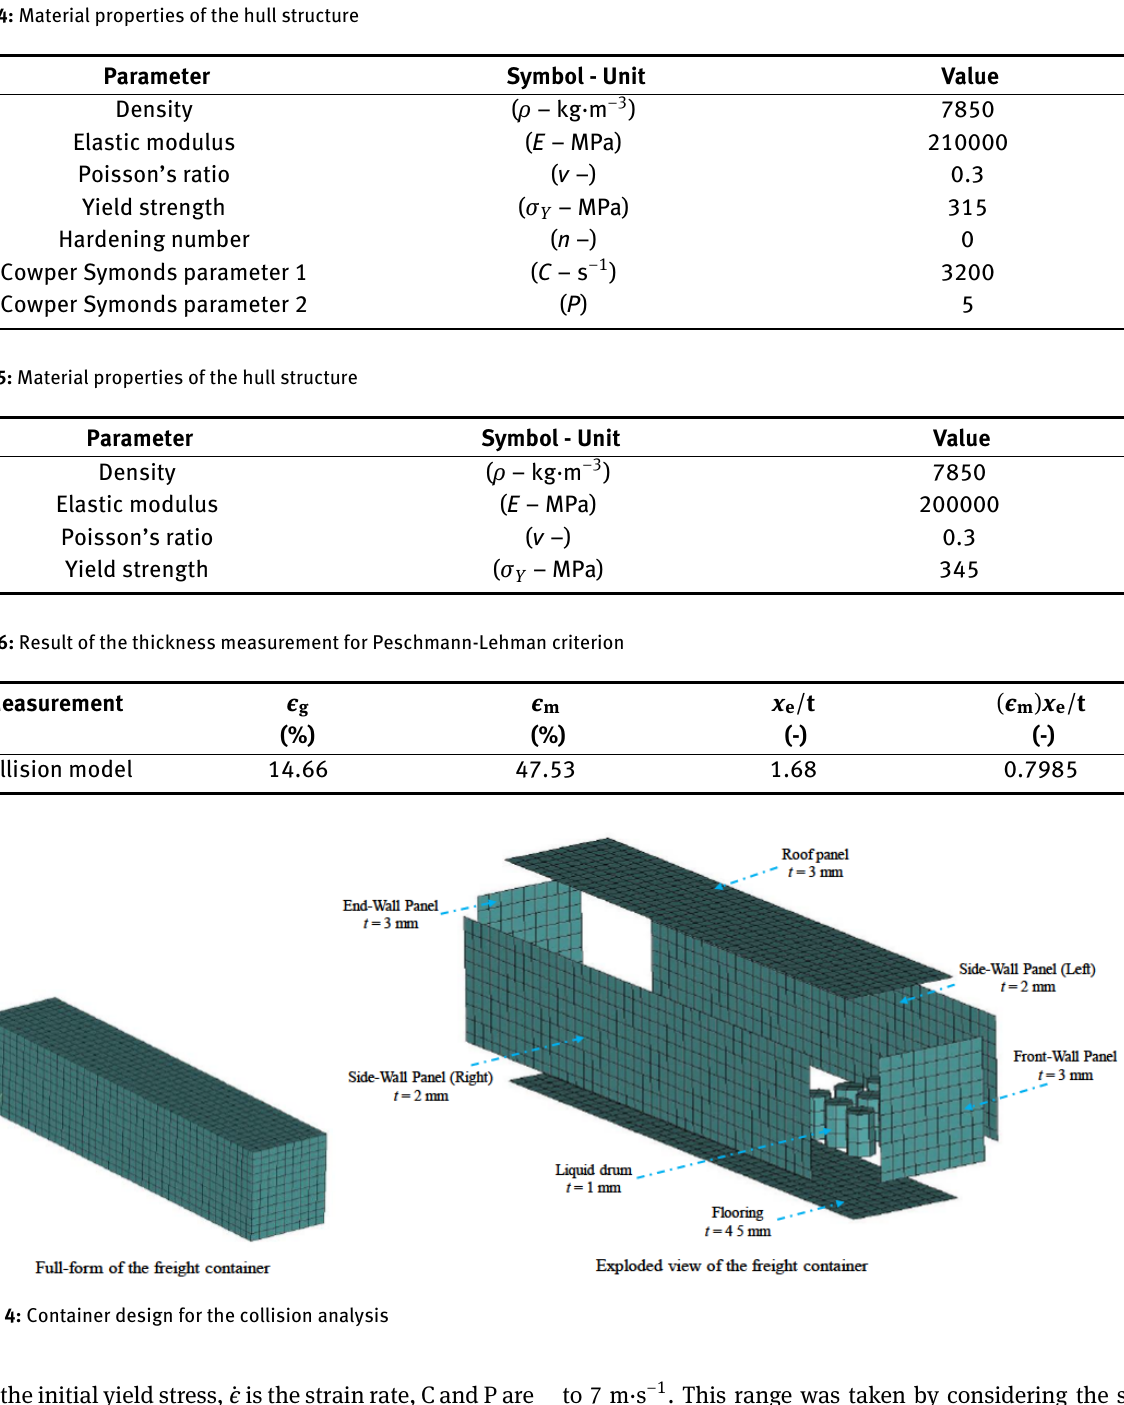
Table 4: Material properties of the hull structure